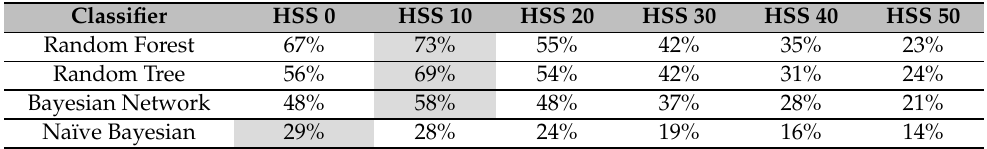
Table 6. Classifier results for 10-fold cross-validation for varying historical set sizes